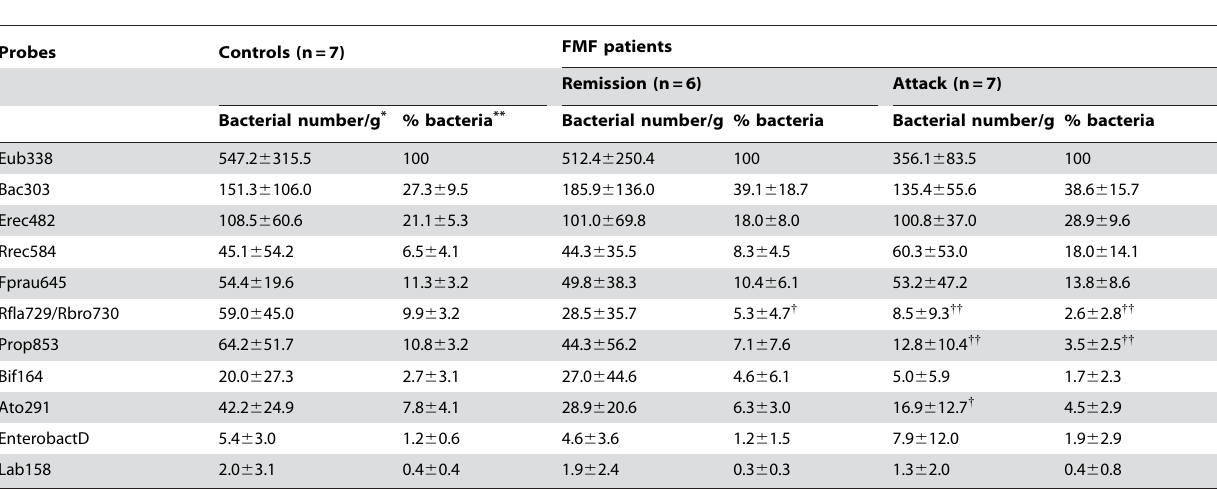
Table 5. Mean numbers of predominant bacteria in fecal samples of FMF patients in both stages of the disease and healthy controls detected by FISH.